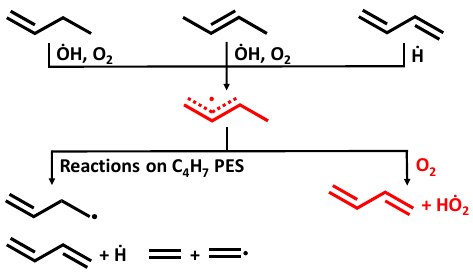
Figure 1. High temperature chemistry of 1-methylallyl (C 4 H 7 1-3) allylic radical.